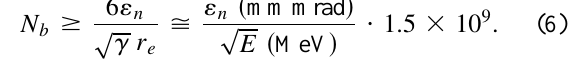
FIG. 3. Experimental setup including (a) focusing solenoid, (b) cathode assembly, (c) plasma confinement solenoid, (d) anode assembly, (e) bend magnet, and (f) phosphor